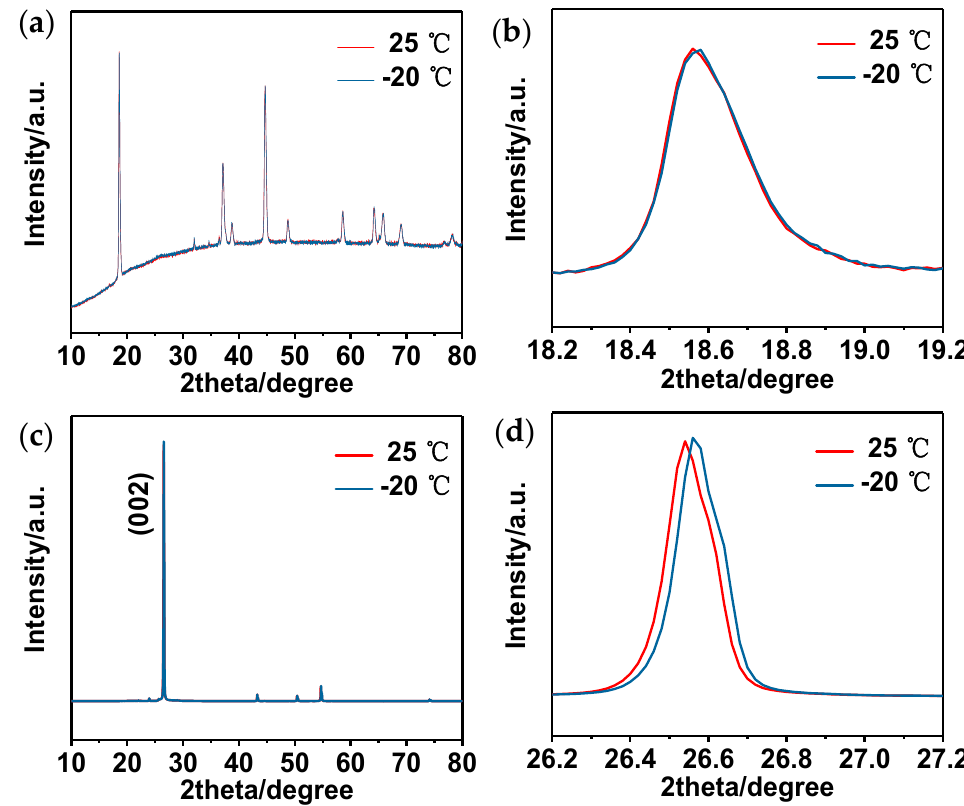
Figure 2. Powder X-ray diffraction (XRD) patterns of ternary Li 1 − x (Ni 0.5 Mn 0.3 Co 0.2 )O 2 in cathode ( a , b ) and SEI-graphite in anode ( c , d ) at 25 and − 20 °C. The charge and discharge curves of normal device at 1 C (100 mA g − 1 ) and 25 °C are